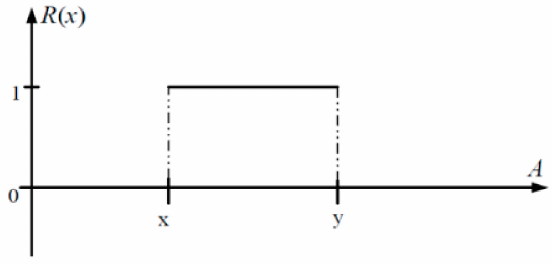
Figure 3. Classic mathematics crisp set.